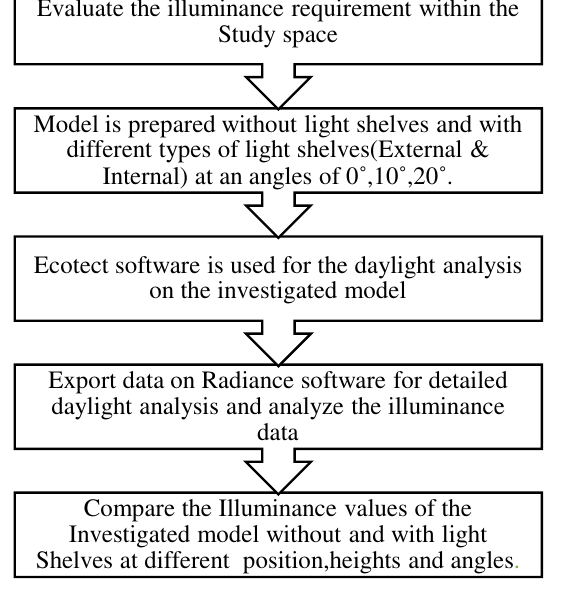
Fig.2: Flow Chart of Research Methodology